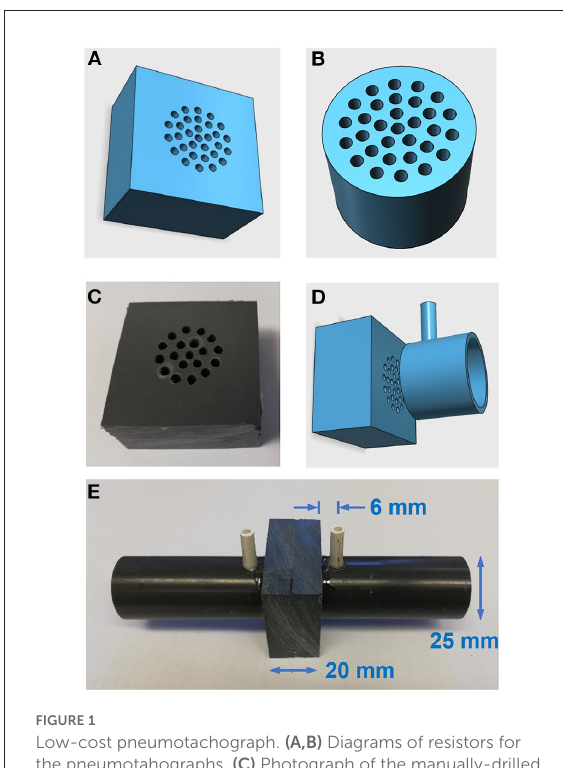
FIGURE1 Low-cost pneumotachograph. (A,B) Diagrams of resistors for the pneumotahographs. (C) Photograph of the manually-drilled resistor. (D) Diagram of resistor and (one side) standard PVC tube to assemble the pneumotach. (E) Photograph of the assembled pneumotachograph.